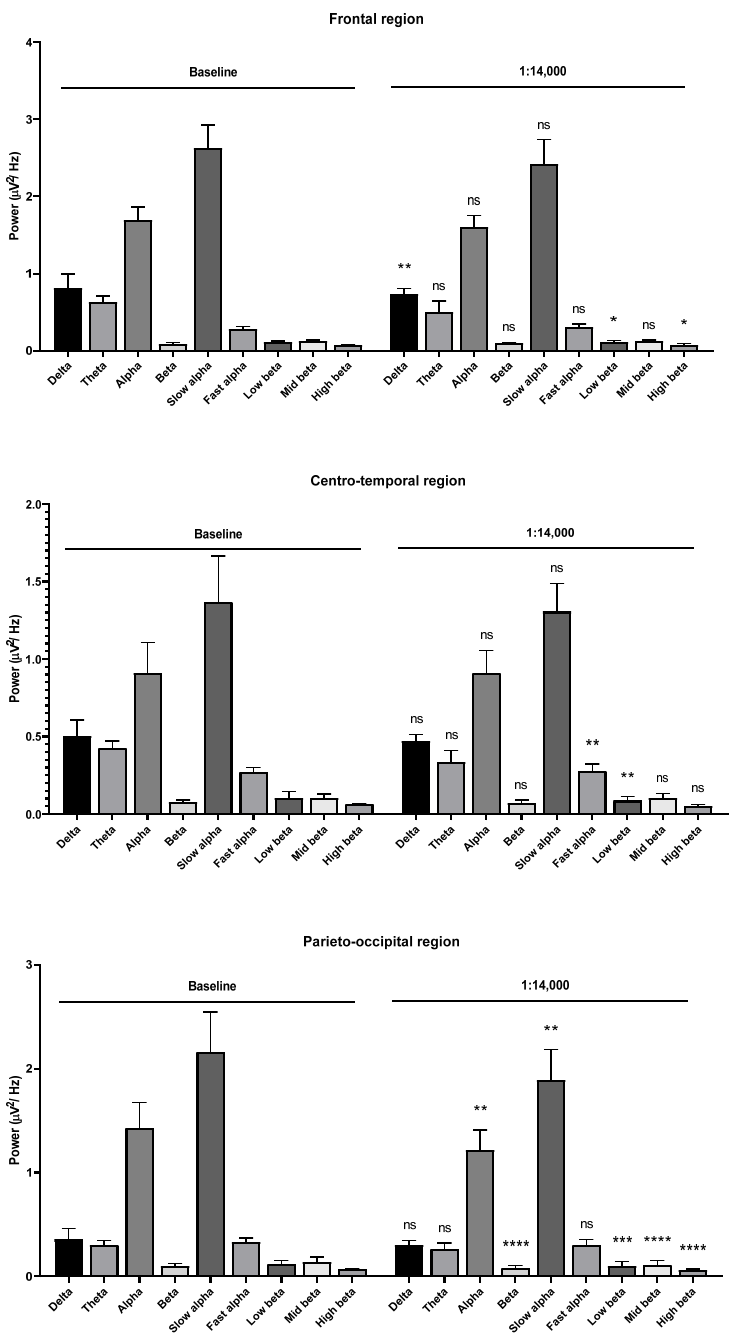
Figure 8. Effects of garlic oil inhalation at a 1:14,000 dilution on the delta, theta, alpha, beta, slow alpha, fast alpha, low beta, mid beta, and high beta wave powers: ( upper ) frontal region; ( middle ) centro-temporal region; ( lower ) parieto-occipital region. p value: not significant (ns) ≥ 0.05, * < 0.05, ** < 0.01, *** < 0.001, and **** < 0.0001.